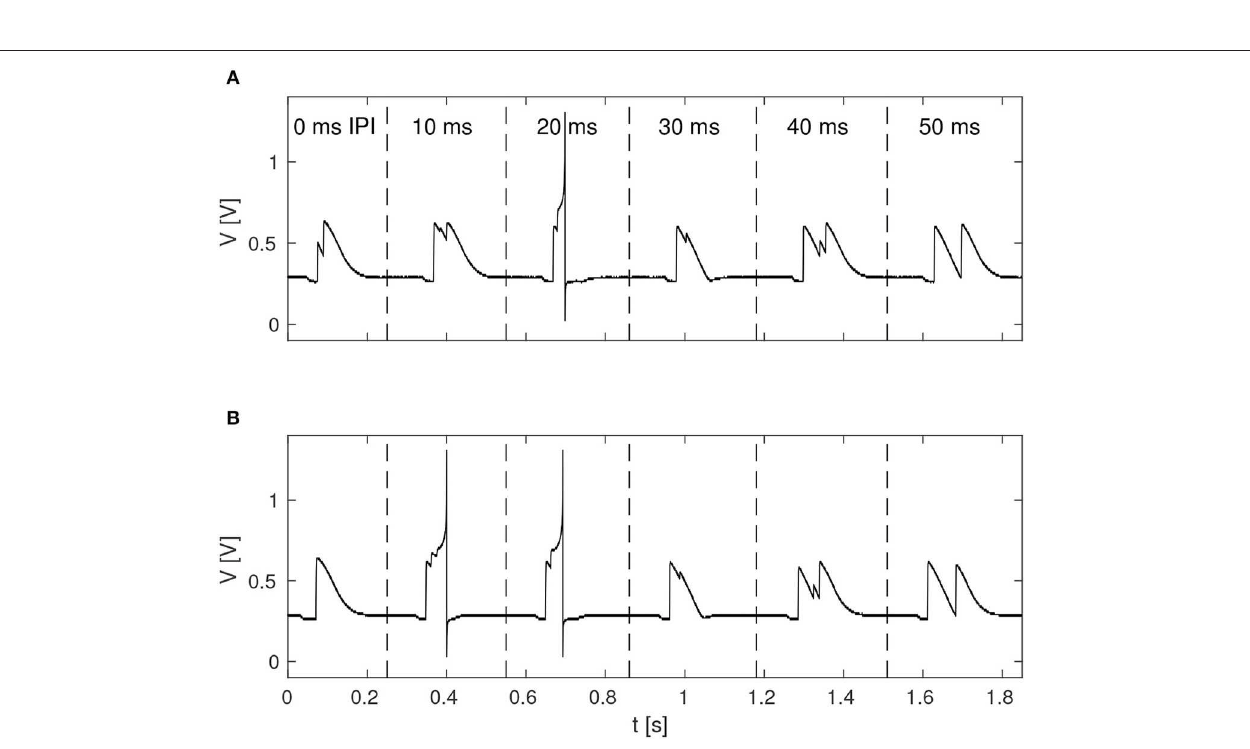
Frontiers in Neuroscience |